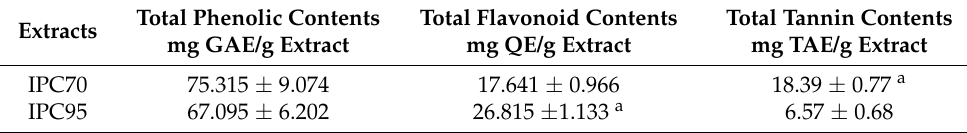
Table 1. Total phenolic, flavonoid, and tannin contents of IPC extracts.